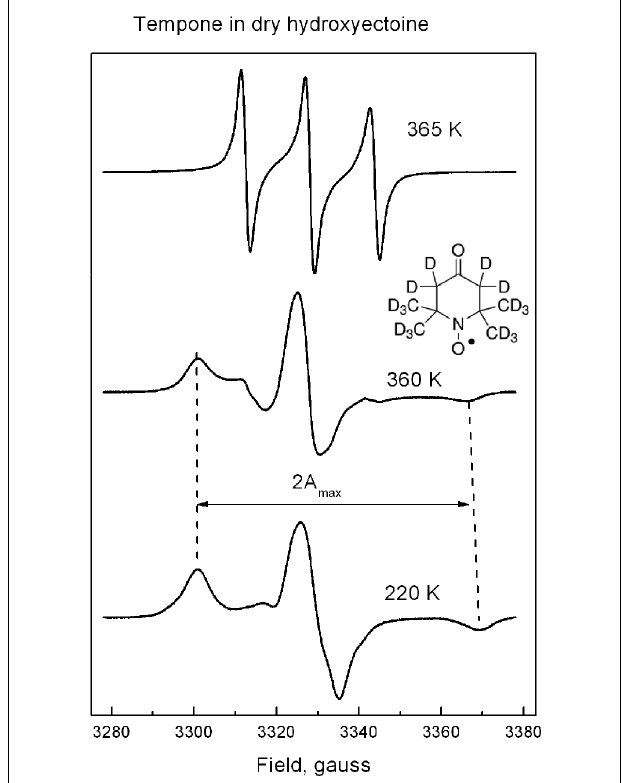
FIGURE 7 |The shape of ESR spectra ofTempone in dry hydroxyectoine at 220, 360, and 365 K. Inset – the molecular structure of perdeuterated Tempone.The way of calculation of 2A max is indicated.